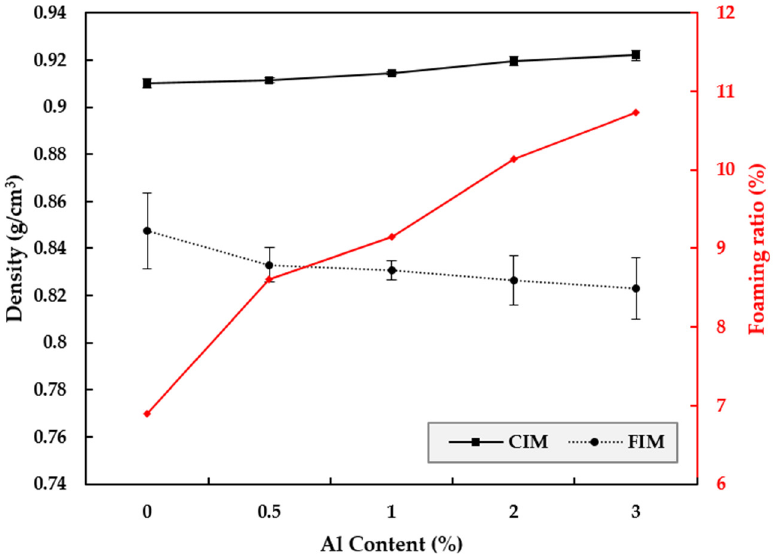
Figure 7. Relationships between density variation and aluminum content and foam rate and aluminum content.